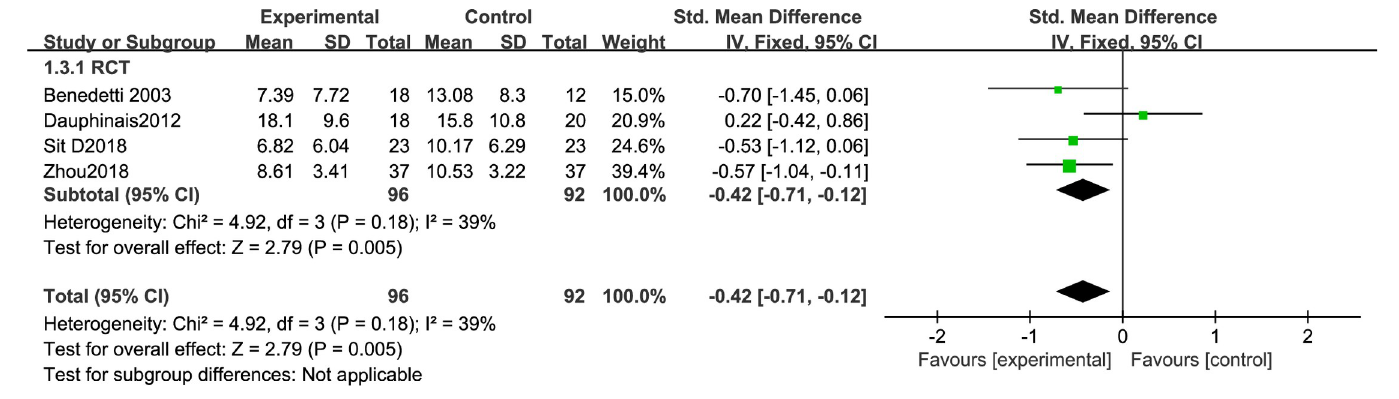
Fig 12. Forest plots without auxiliary measures.